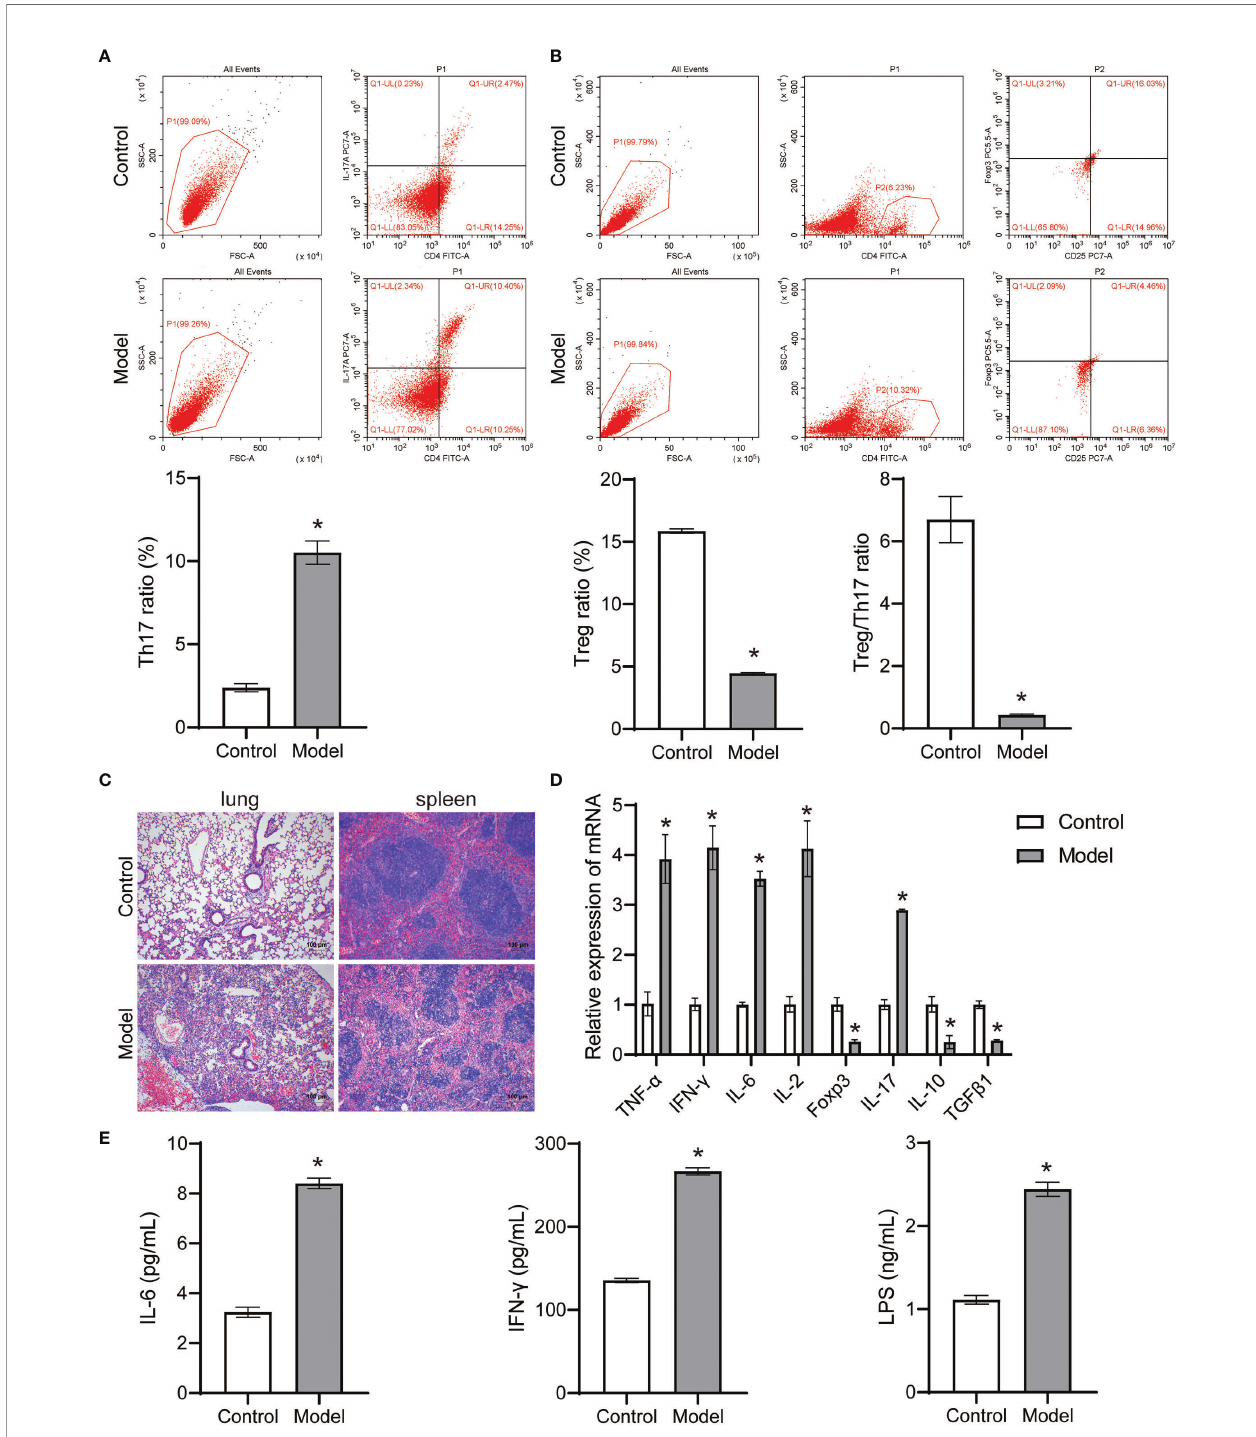
FIGURE 3 | Pseudomonas aeruginosa induced immune differentiation and in fl ammation of mice (n=10 mice/group). (A, B) The Treg and Th17 cells ratio in spleen tissues were analyzed by fl ow cytometry. (C) Histopathological changes of lung and spleen were observed by HE staining (100×). (D) The expression of TNF- a , IFN- g , IL-6, IL-2, Foxp3, IL-17, IL-10 and TGF b 1 in lung tissue homogenate was detected by qRT-PCR. (E) Serum IL-6, LPS and IFN- g levels were detected by ELISA. * P < 0.05 vs control group. Each sample was replicated 3